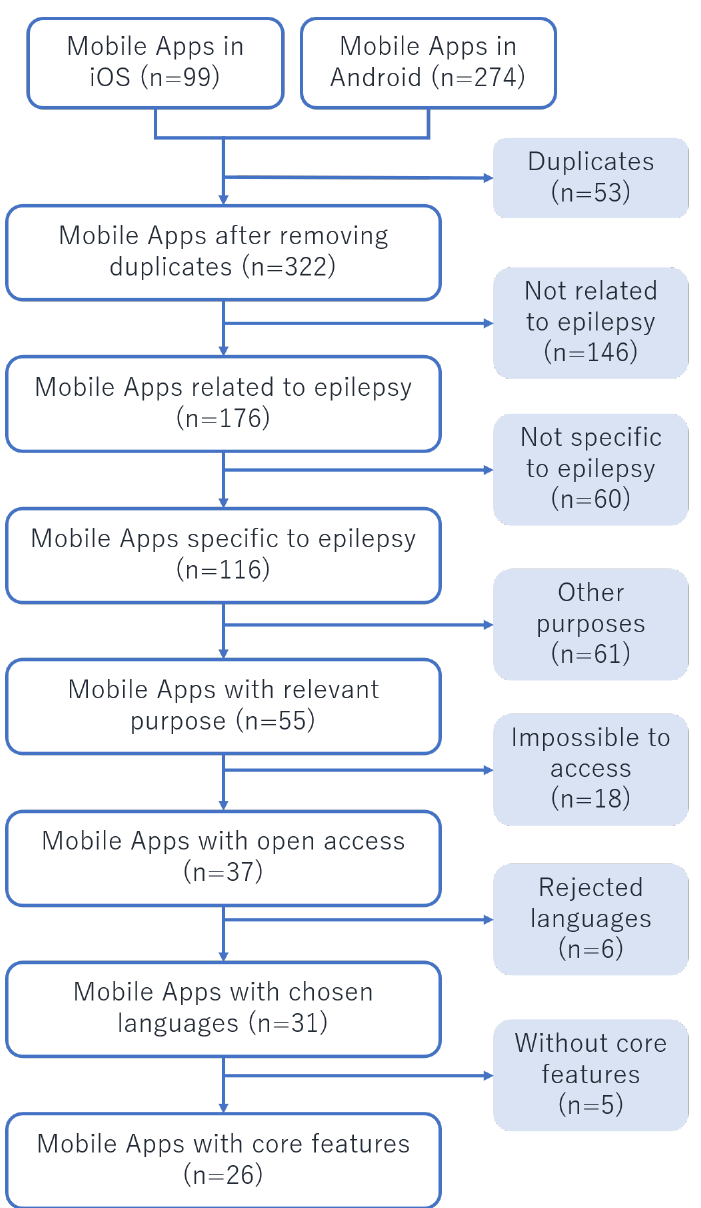
Figure 1. PRISMA scheme for the selection of the relevant mobile apps, according to hierarchical criteria: (1) related to epilepsy; (2) specific for epilepsy; (3) with relevant purpose; (4) with